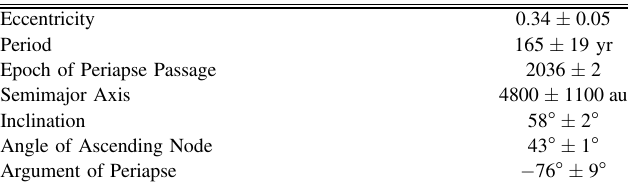
Argument of Periapse − 76 ° ± 9 ° Note. The listed numbers are median values and 68% con fi dence intervals. Uncertainties are statistical